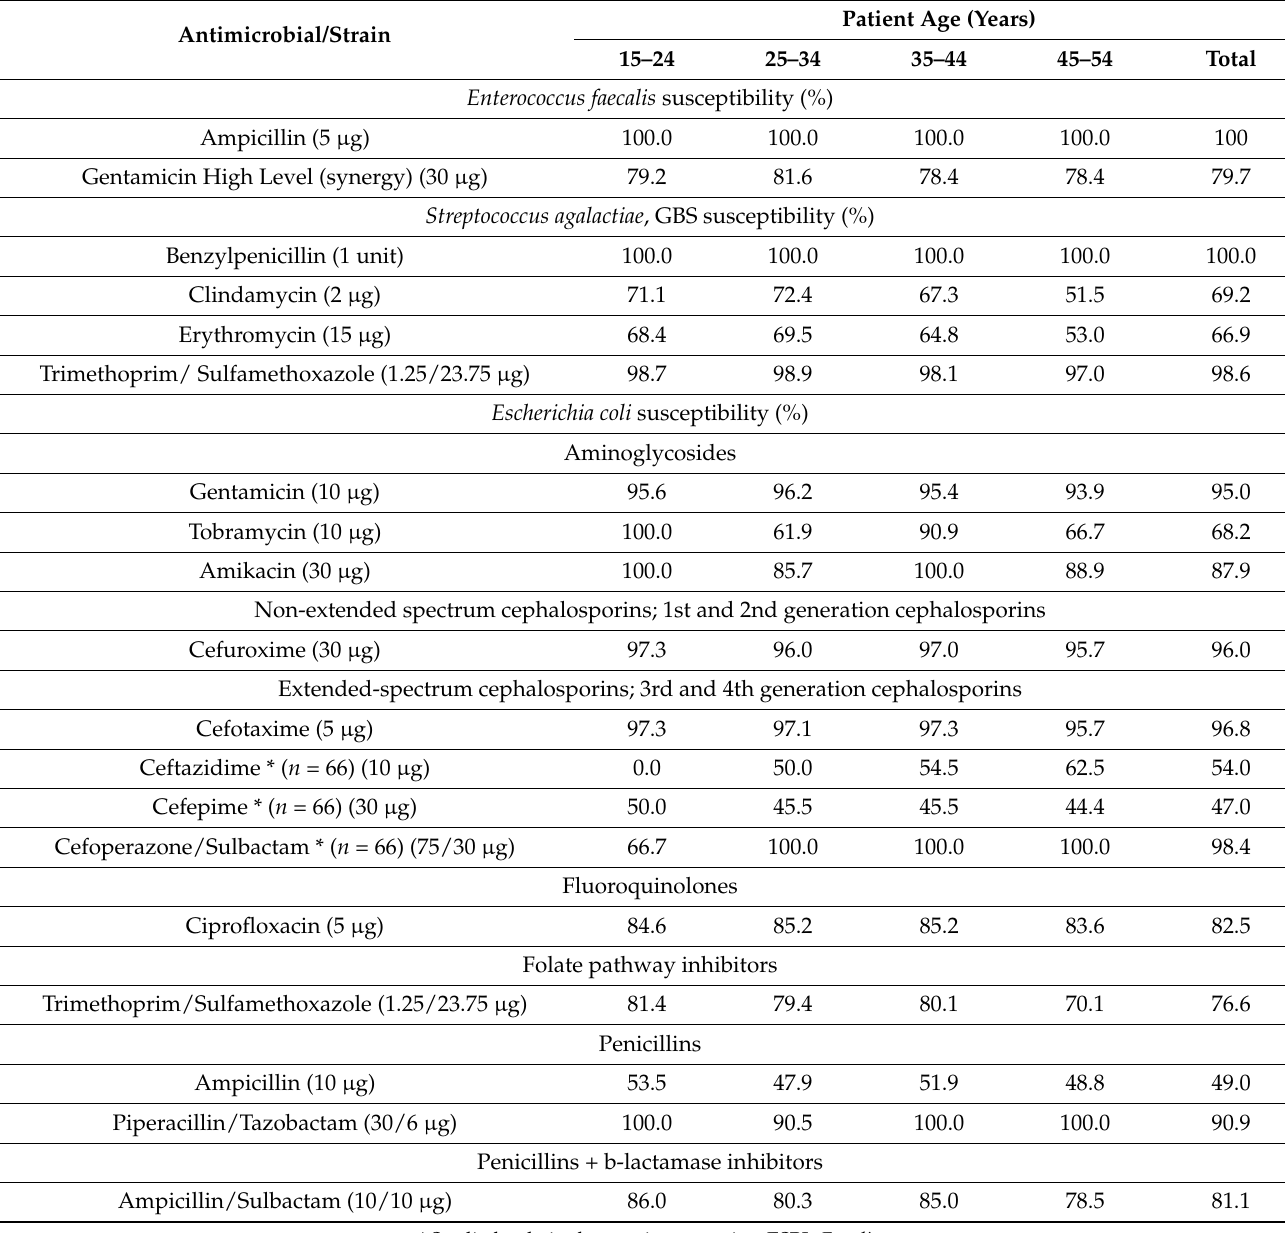
Table 2. Antimicrobial susceptibility of selected microorganisms isolated from infections according to patients’ age.